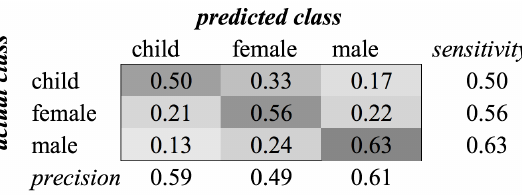
Figure A5. SVM confusion matrix of category Gender for MFCC feature type.